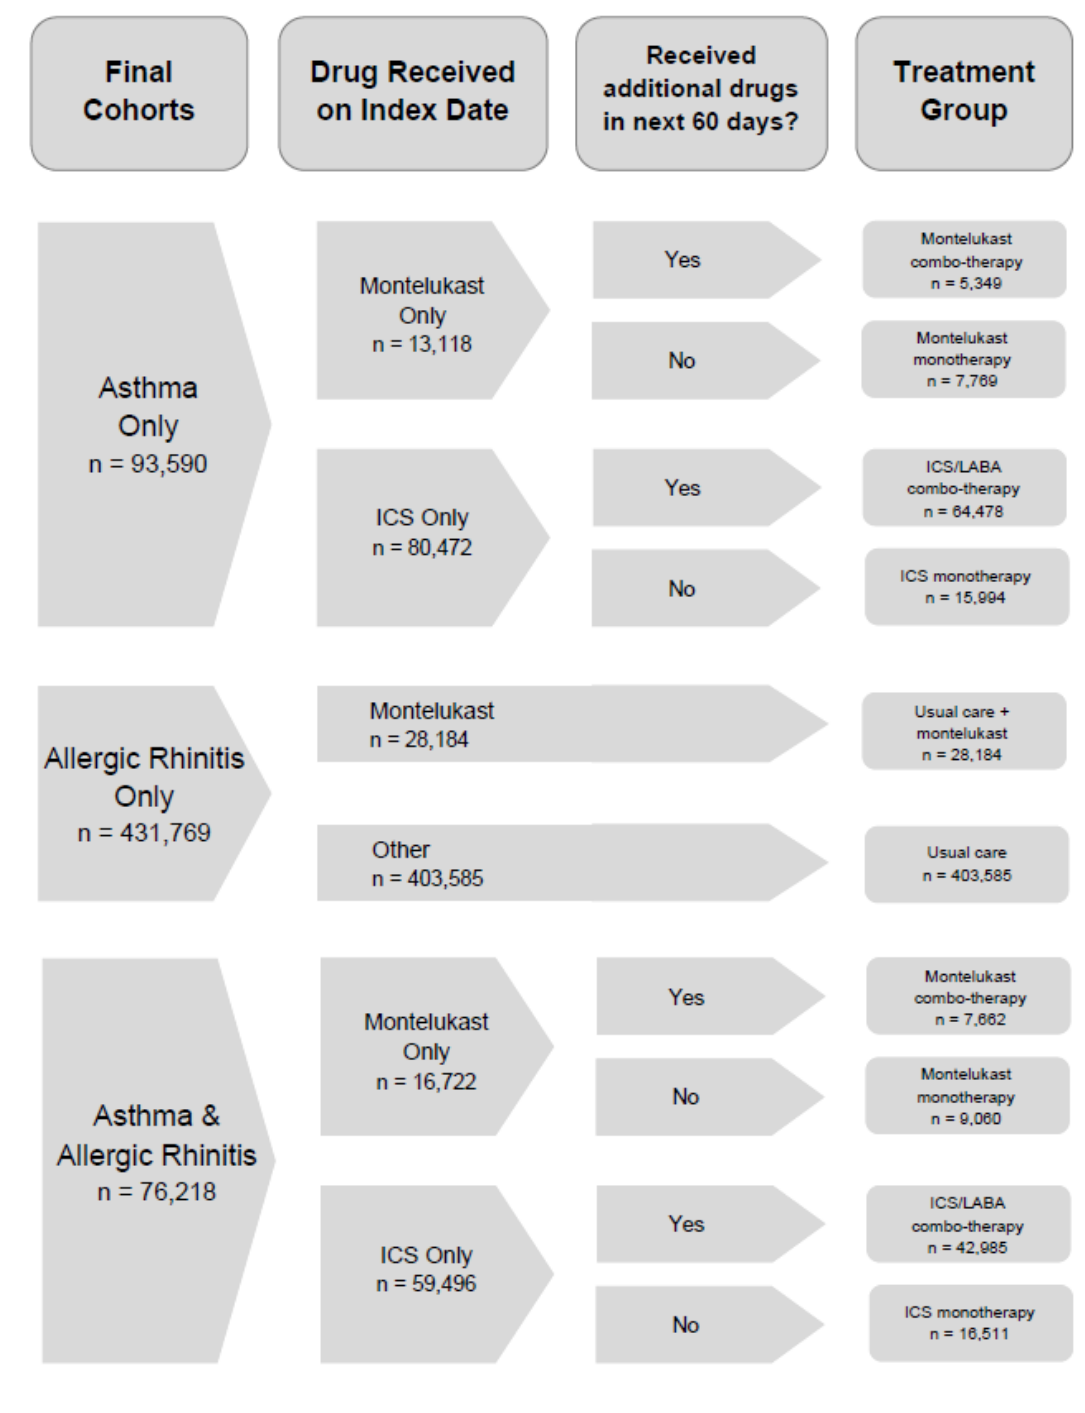
Figure 3. Flow of Patients to Treatment Group